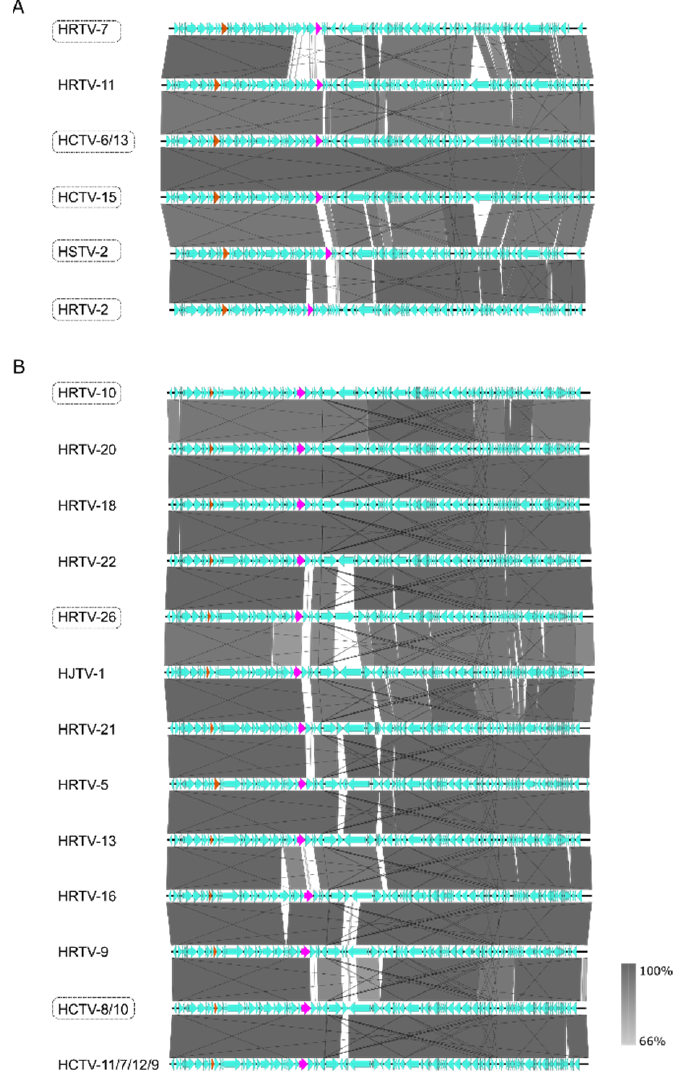
Figure 4. Schematic genomic alignment of the ( A ) mincapviruses, and ( B ) haloferacalesviruses. Grey bars represent homologous genomic regions. The level of nucleotide identity is reflected by the intensity of grey. Genes encoding major capsid protein (orange) and adhesins (pink) are indicated. The LR2-5 infecting viruses are circled with dashed lines. Identical or very similar genomes are shown as one and virus names are separated by /. Figures are prepared with Easyfig. Another highly variable region in the viral genomes is located around genes encoding the viral tail fiber and adhesin (Figures 4 and 5). Adhesins, located at the distal tip of the tail fibers, have been shown to be the host determinants in the tailed dsDNA bacteriophages of the order Caudoviricetes [17]. Long tail fibers of bacteriophages have a modular organization, and they consist of several different proteins [18,80]. Moreover, it has been suggested that haloarchaeal tailed viruses exchange the genes encoding either the tail fiber or adhesin with other viruses by recombination [10]. All haloferacalesviruses and mincapviruses have a gene encoding for a putative tail fiber protein together with a gene encoding a putative adhesin [10]. HFTV1 is a siphovirus with a long non-contractile tail, and it does not contain tail